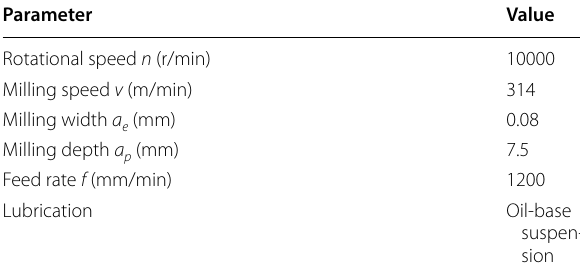
Table 3 Cutting parameters adopted in the cutting tests